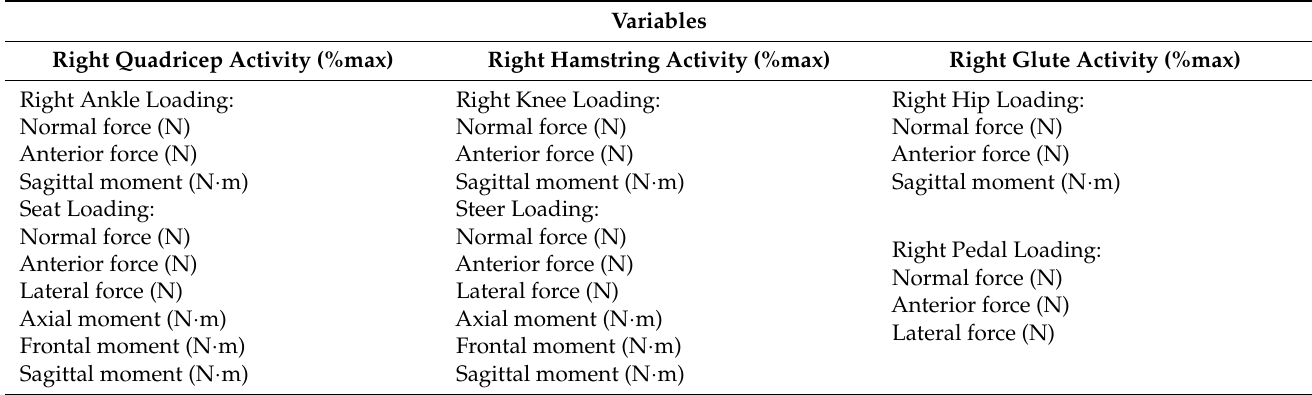
Table 2. List of analyzed